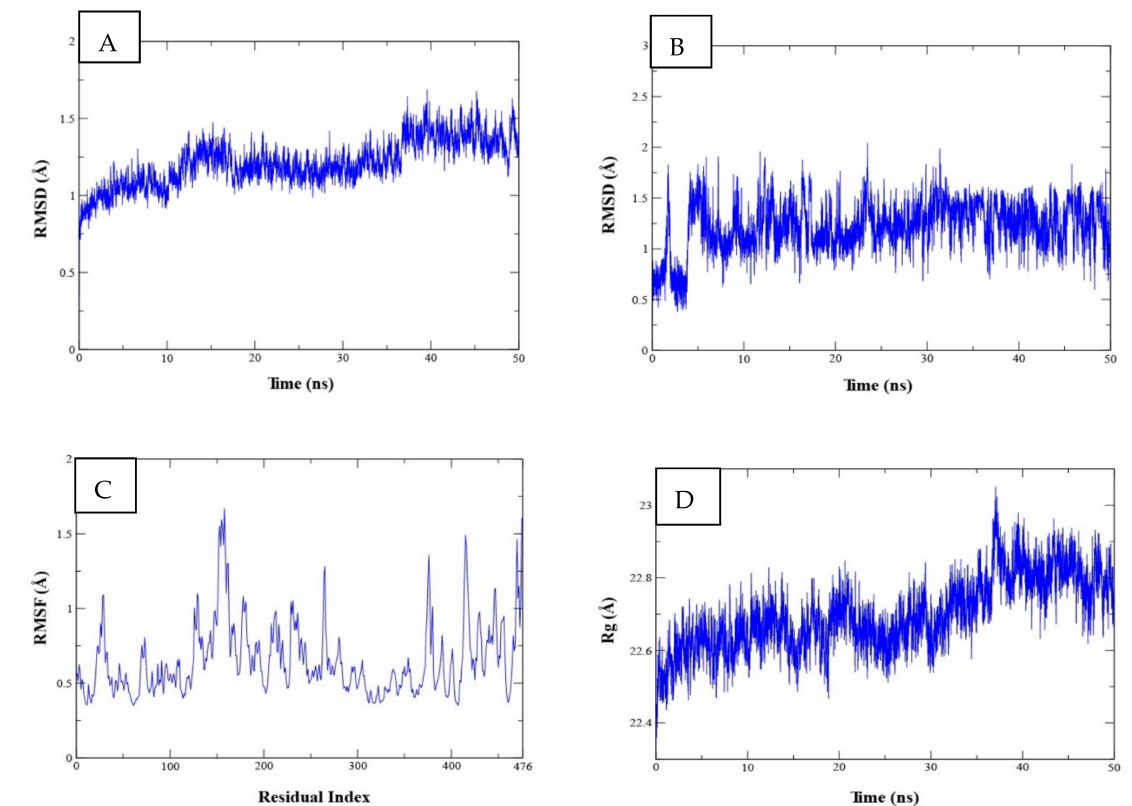
Figure 4. The MD simulation analysis of α -amylase during 50 ns. ( A ) shows the RMSD of protein backbone atoms. ( B ) shows the RMSD of ligand atoms. ( C ) shows the RMSF of each residue of protein. ( D ) shows the Rg of the protein